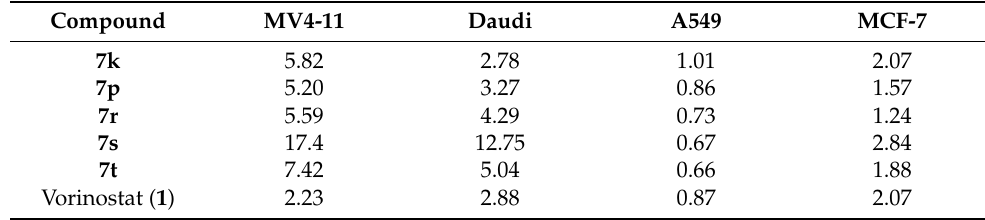
Table 4. Selectivity index (IC 50 of normal vs. cancer cells). SI > 1.0 indicates a compound of greater activity against cancer cells and lower cytotoxicity on normal cells.